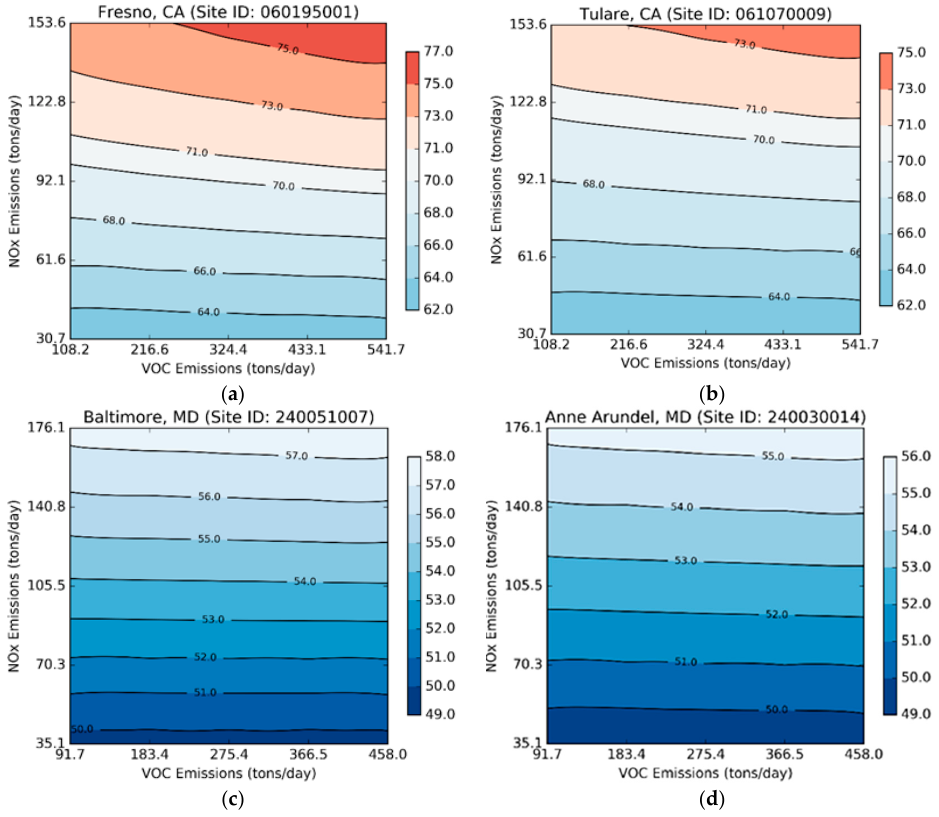
Figure 3. Future-year ozone design value isopleths (ppb) for monitors in ( a ) Fresno, CA; ( b ) Tulare, CA; ( c ) Baltimore, MD; and ( d ) Anne Arundel, MD.